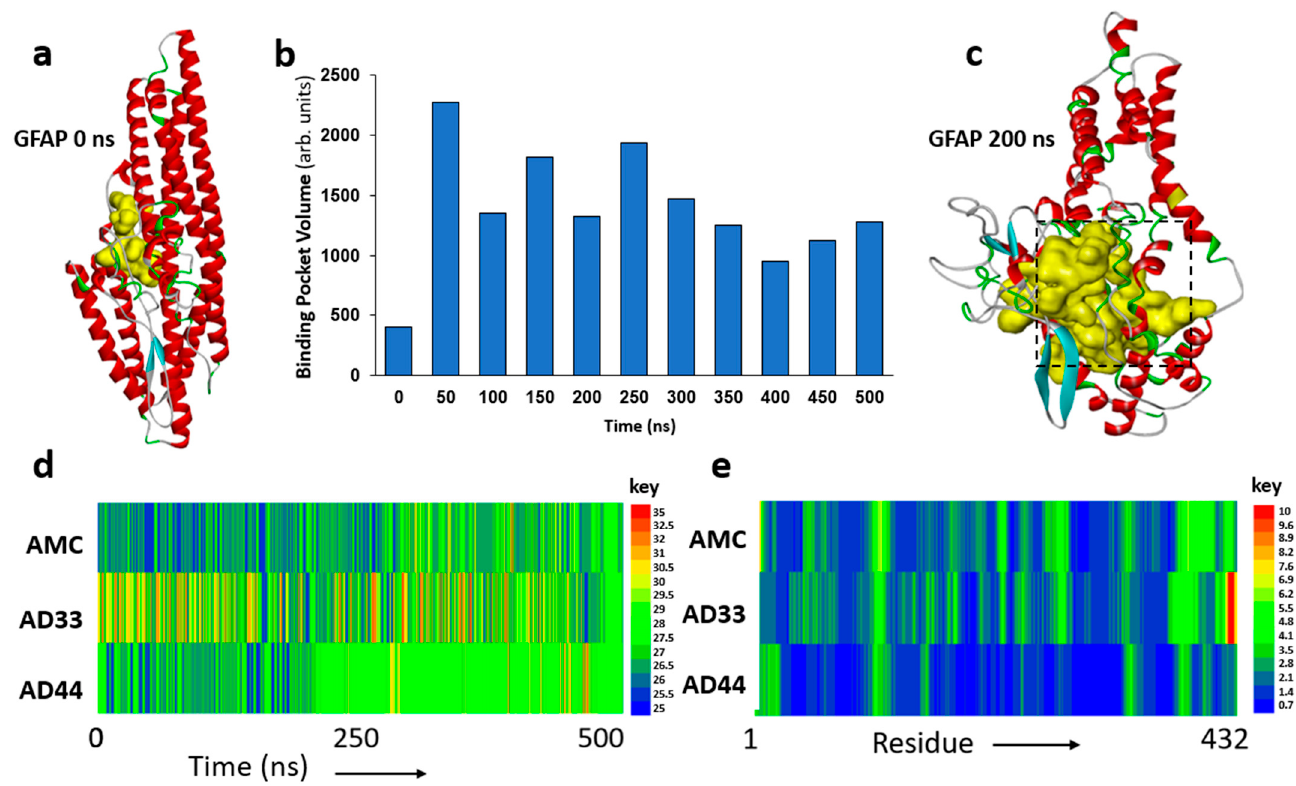
Figure 2. Molecular dynamic analyses of GFAP structure. ( a ) Initial modeled structure of GFAP. Yellow internal cavity is the predicted drug ‐ binding pocket. ( b ) Predicted binding pocket volume for GFAP at 50 ns intervals over a 500 ns span. ( c ) Predicted cavity for ligand binding (yellow) at 200 ns. ( d ) Time course of root mean squared deviation (RMSD) for GFAP structure, comparing 500 ns in silico simulations of AMC (unmodified) GFAP to GFAP with phosphomimetic substitutions to mimic AD(3,3) and AD(4,4). ( e ) Distribution across GFAP (432 residues) of root mean squared fluctuation (RMSF) to illustrate positional variability by residue. ( d , e ) Keys to the right of panels d and e display the color codes for RMSD and RMSF values,